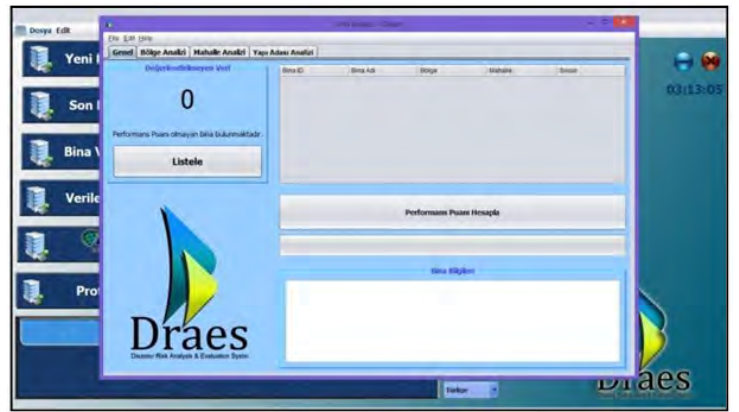
Figure 11. Analysis of Data